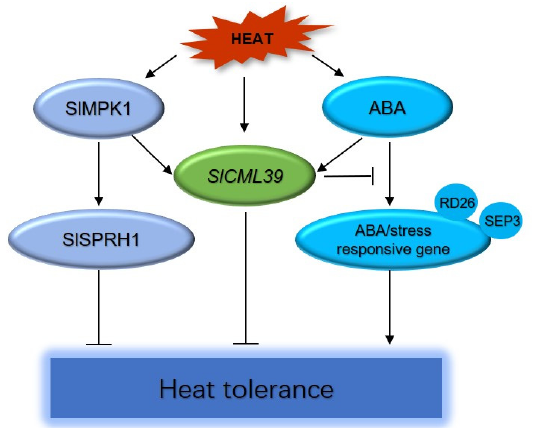
Figure 10. The model of SlCML39 as a hub connecting the ABA signal and ABA-mediated heat tolerance. Under heat stress, phosphorylation of the SlMPK1 activates downstream target proteins SlSPRH1, resulting in decreased thermotolerance [26]. Heat-induced SlCML39 expression is medi- ated by SlMPK1, and is involved in negative regulation of heat tolerance. Under heat stress, SlCML39 expression is induced, acts downstream of ABA signal, and inhibits the expressions of ABA/stress-responsive genes, resulting in decreased thermotolerance. The NAC transcription factor RD26/ANAC072 and MADs box transcription factor SEP3 are involved.